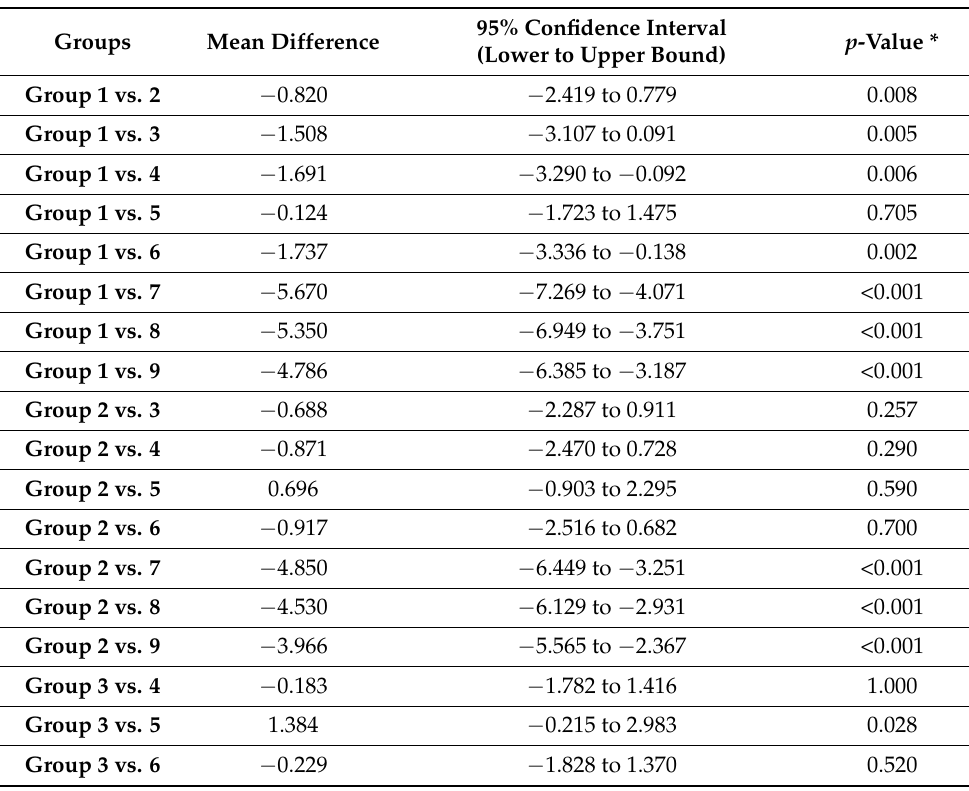
Table 3. Multiple comparisons between all sealer–technique